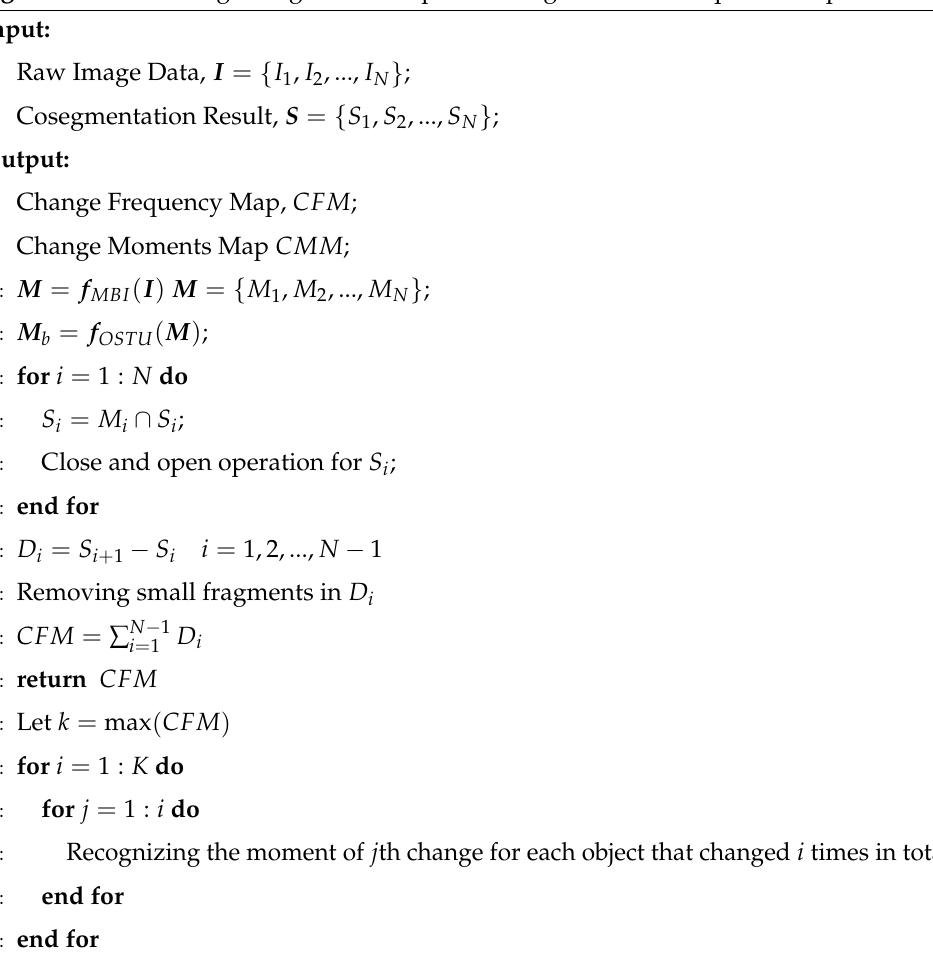
Algorithm 1 Extracting change times map and change moments sequence